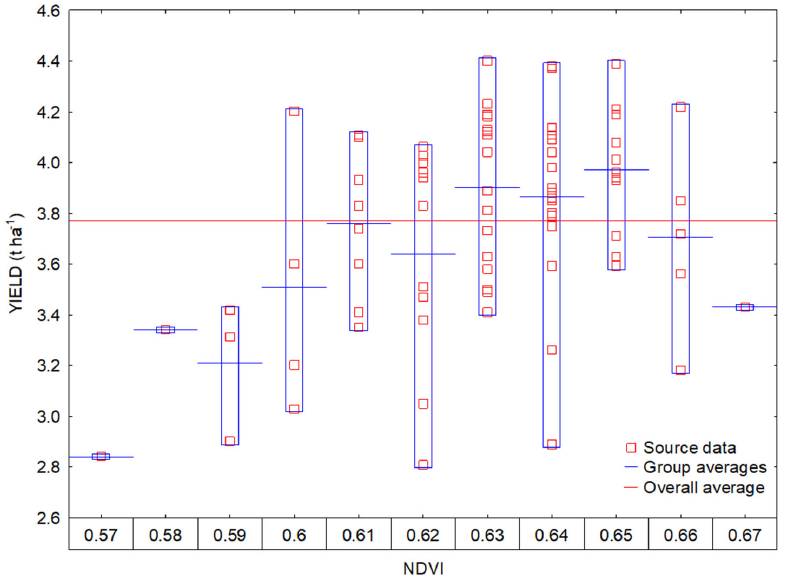
Figure 8. Graph of the variance of YIELD variable in relation to the measured NDVI values (N = 80). Source data (red squares) show the yields of each plot ( Y − axis) divided into 11 groups according to NDVI measured on each plot, ranging from 0.57 to 0.67 (11 values; X − axis). The parcels in each of the 11 groups have the same NDVI value.